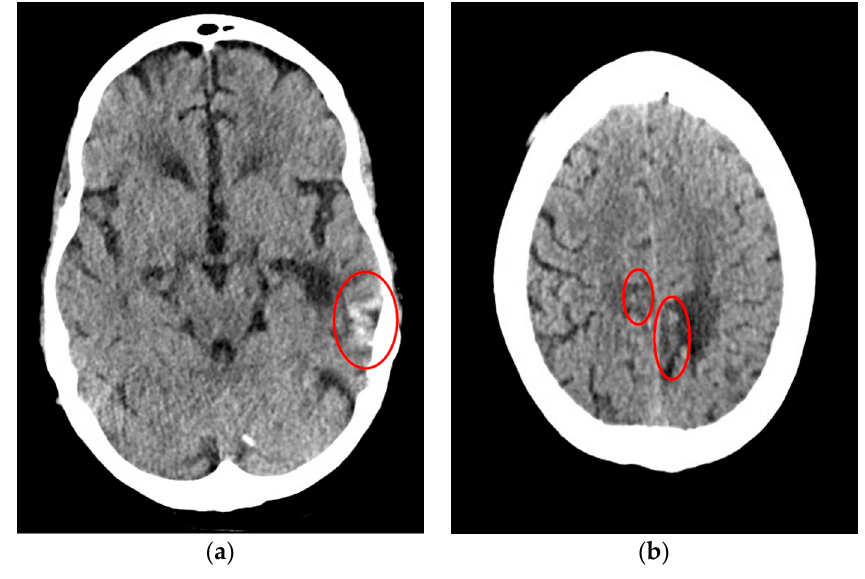
Figure 1. Computed tomography (CT) head of a 61-year-old male with SCNS-DLBCL presenting with acute encephalitis. ( a ) CT Head shows a small area of inferolateral left temporal density, which correlates with the blood products that were seen in patient’s previous magnetic resonance imaging (MRI) associated with the temporal lobe lesion. There is associated white matter low density, which is similar to the non-enhancing signal on previous MRI; ( b ) CT Head shows a small area of medial left parietal occipital low density corresponds to the lesion and old blood seen on the MRI. It also shows a very small area of medial right parietal occipital low density corresponds to signal seen on the MRI.